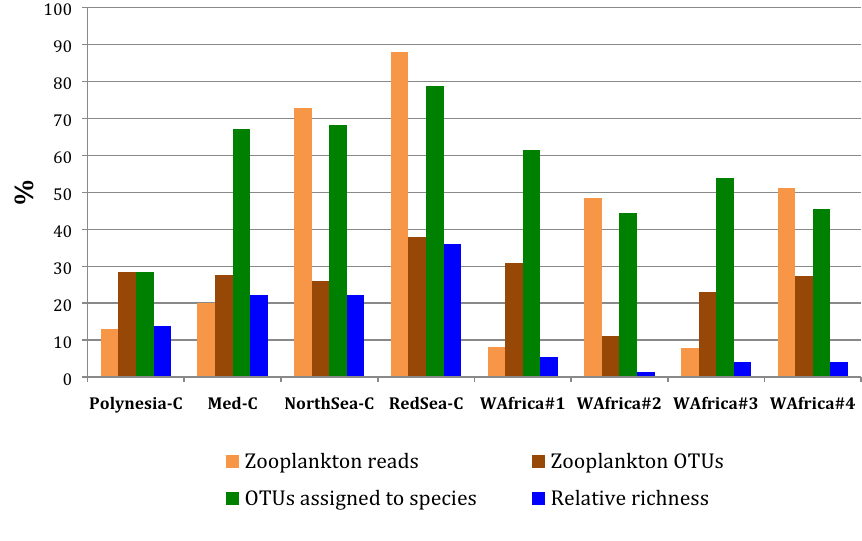
Figure 2. Overview of NGS metabarcoding results in the samples analyzed, as: percent of zooplankton reads or OTUs, and percent of OTUs assigned to a species level in each sample. Relative richness: % of species in a sample over the total number of species detected from metabarcoding in this